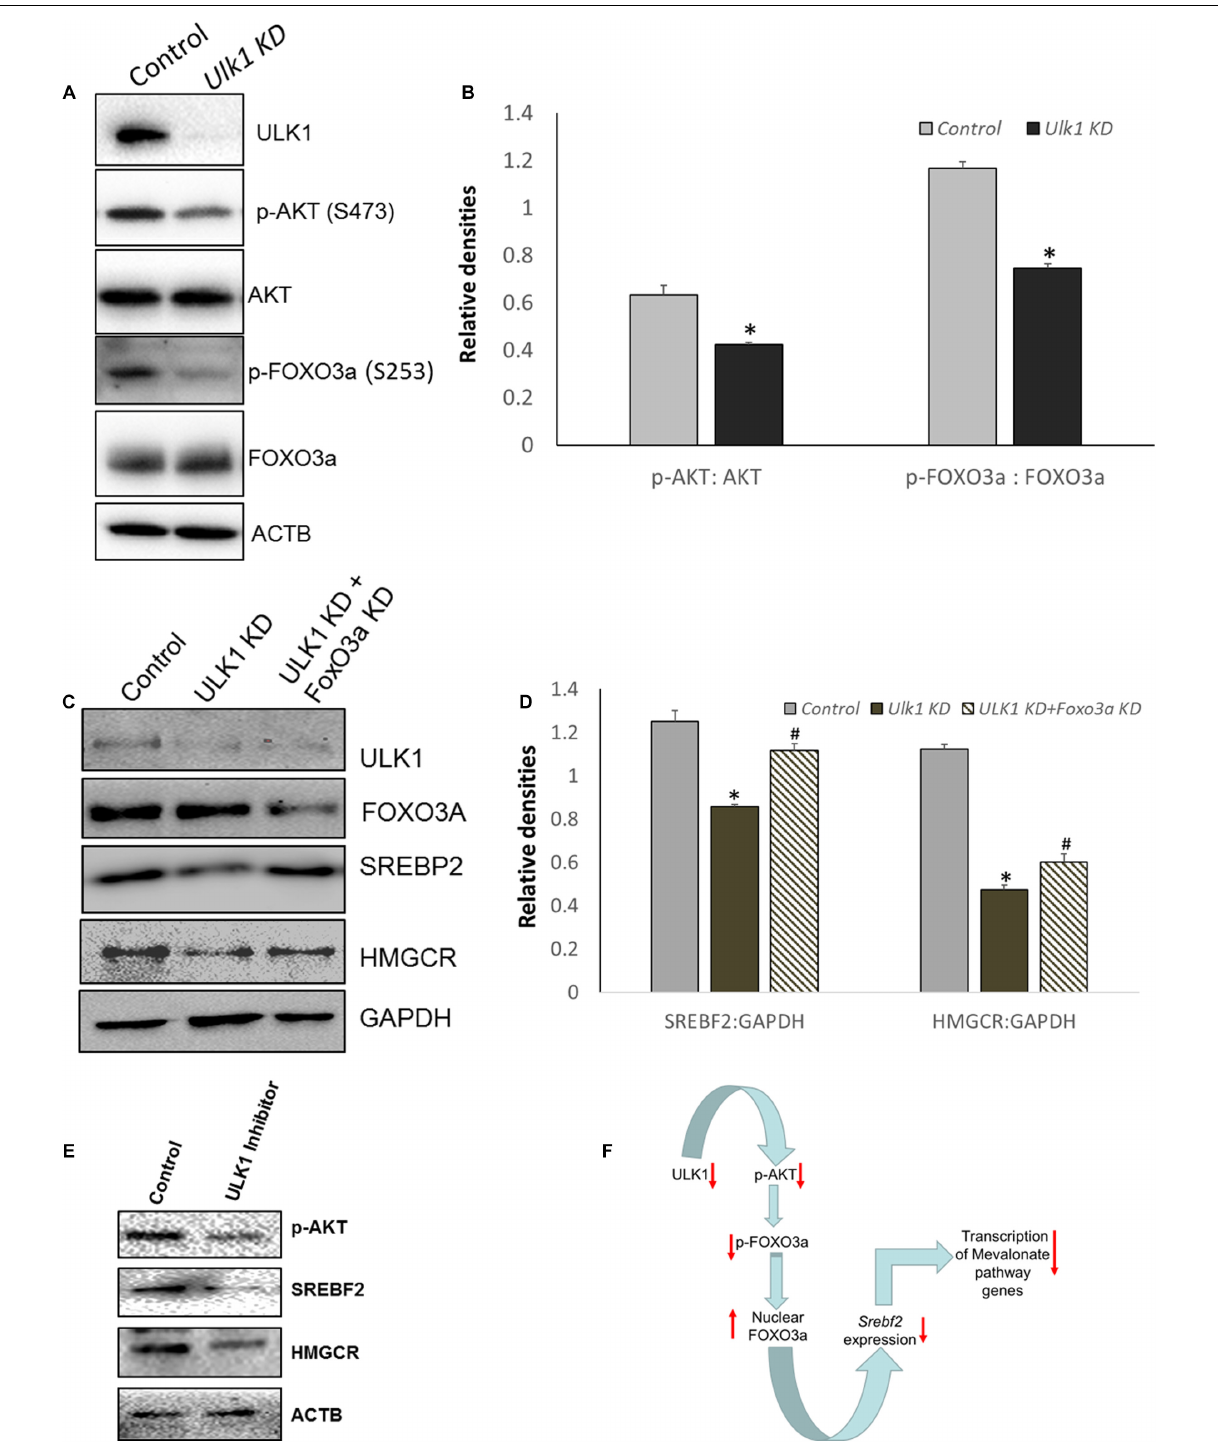
FIGURE 4 | ULK1 loss suppress human cholestrogenic genes via effects on AKT-FOXO3a pathway. (A,B) Representative immunoblot and densitometry showing cellular levels of phosphorylated and total AKT and FoxO3a proteins ± Ulk1 siRNA (10 nM/48 h) in HepG2 cells. Values are means ± SD ( n = 3), ∗ p < 0.05. (C,D) Representative Immunoblot and densitometry showing protein levels of SREBF2 and HMGCR in HepG2 ± Ulk1 alone and with FoxO3a (Cell Signaling Technology, #6302) double KD (10 nM) for 48 h of treatment. Values are means ± SD ( n = 3), ∗ p < 0.05 between Ulk1 KD vs. Control and # p < 0.05 between Ulk1 KD + FoxO3a KD vs. Ulk1 KD alone. (E) Representative immunoblot of HepG2 cells treated with SBI-0206965 (ULK1 inhibitor) at a dose of 10 uM for 48 h. (F) Schematic diagram showing the regulation of Mevalonate/cholesterol biosynthesis pathway upon loss of ULK1.